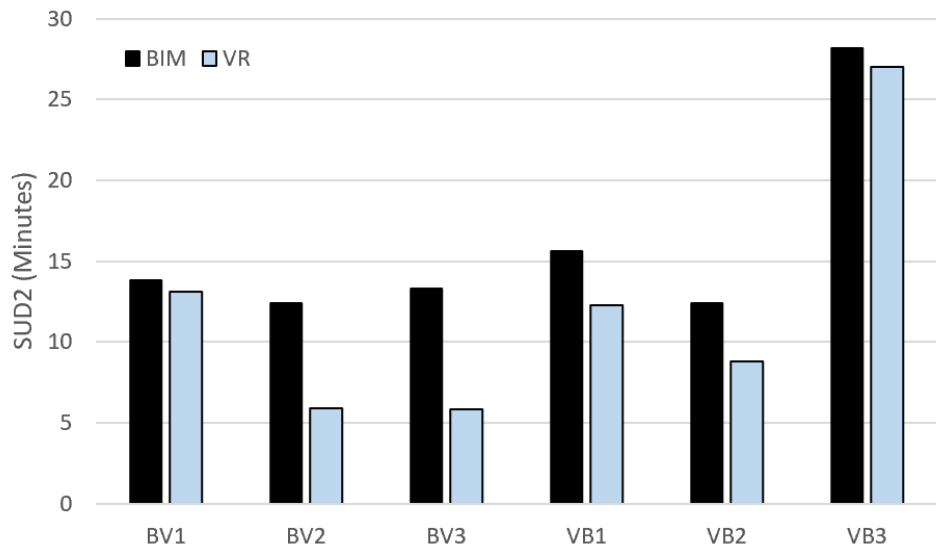
Figure 9. Time spent by each group in two platforms of BIM and VR to build Shared Understanding of the alternative design.